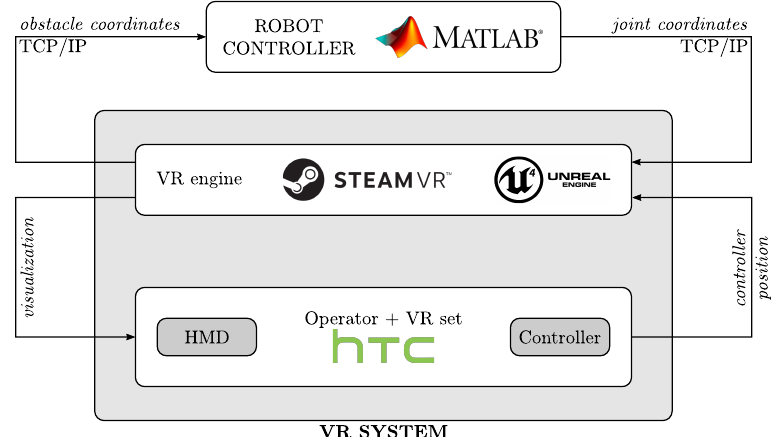
Figure 9. Architecture of the control loop for the VR application.